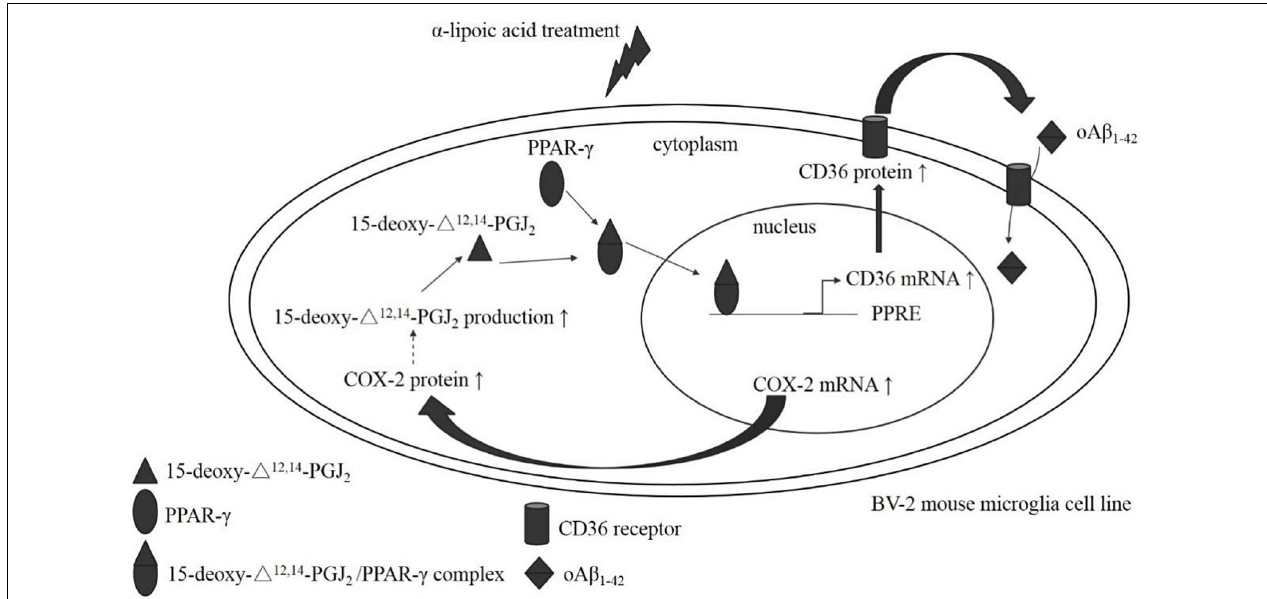
FIGURE 10 | The postulated mechanism of ALA in enhancing oA β 1 − 42 phagocytosis in BV-2 mouse microglial cells. BV-2 mouse microglial cells made a difference after ALA stimulation, which caused the elevation of COX-2 mRNA and the increased translation of the COX-2 protein. Furthermore, the COX-2 protein induced 15-deoxy- (cid:49) 12 , 14 -PGJ2 production and the 15-deoxy- (cid:49) 12 , 14 -PGJ2 acted on the PPAR- γ ligand. Simultaneously, the 15-deoxy- (cid:49) 12 , 14 -PGJ2/PPAR- γ complex translocated from the cytoplasm to the nucleus. PPAR- γ that located the nucleus stimulated the transcription of the CD36 gene, which promoted the synthesis of CD36 mRNA. The increase in CD36 mRNA promoted the translation of the CD36 protein. Finally, the elevated level of the CD36 protein enhanced the phagocytosis of oA β 1 − 42 in BV-2 mouse microglial